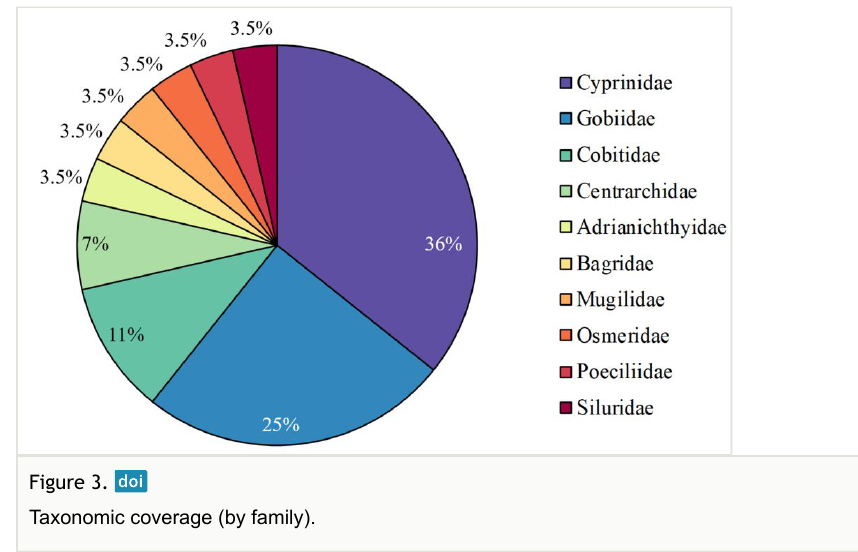
Figure 3. Taxonomic coverage (by According to the Red Data Book published by Kanagawga Prefecture (2006), Tanakia lanceolata (Temminck & Schlegel, 1846) was determined to be extinct. Oryzias latipes (Temminck & Schlegel, 1846) and Pseudobagrus tokiensis (Döderlein, 1887) were determined to be critically endangered. Lefua echigonia (Jordan & Richardson, 1907) was determined to be endangered. Rhynchocypris lagowskii steindachneri (Dybowski, 1869), Pseudogobio polystictus (Tominaga & Kawase, 2019), Rhinogobius giurinus (Rutter, 1897), Cobitis biwae (Jordan & Snyder, 1901) and Gymnogobius petschiliensis (Rendahl, 1924) were determined to be Near Threatened (NT). Silurus asotus (Linnaeus 1758) was identified as N (noteworthy). In addition, Cyprinus carpio (Linnaeus, 1758) is listed as DD (data deficient). Amongst these species, Pseudobagrus tokiensis , Oryzias latipes , Lefua echigonia and Tanakia lanceolata were also listed in the Red Data Book of the Ministry of the Environment for the entire nation (Ministry of the Environment 2020).